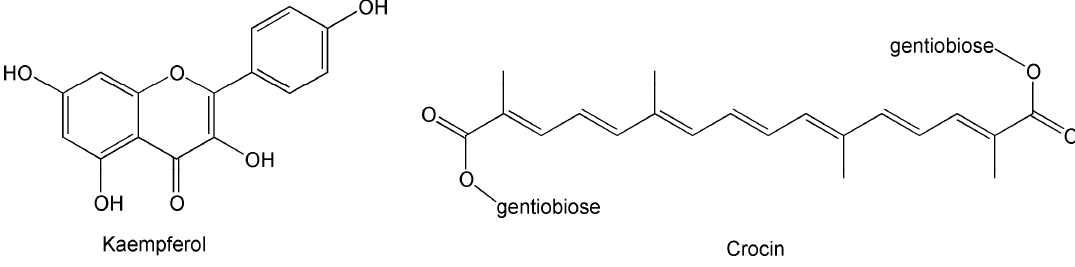
Figure 1. Chemical structures of kaempferol and crocin.